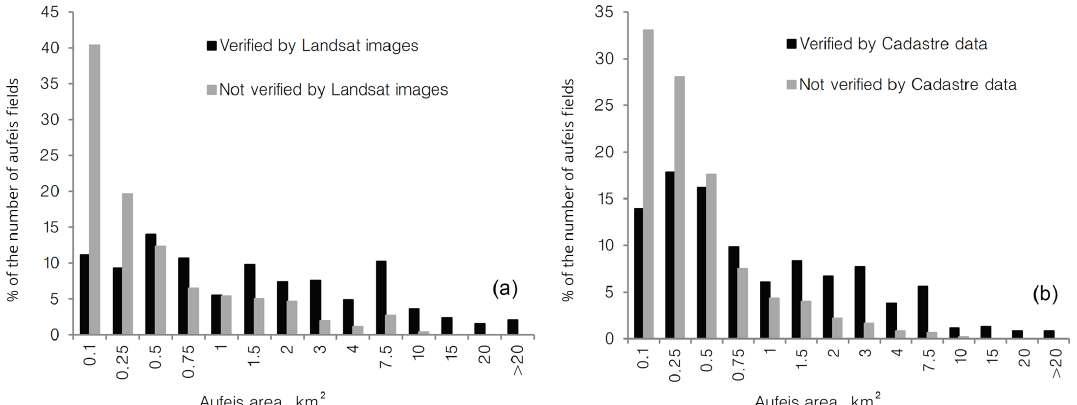
Figure 5. Aufeis area distribution: (a) according to the Cadastre data, confirmed and not confirmed by Landsat images and (b) according to Landsat images, confirmed and not confirmed by the Cadastre.